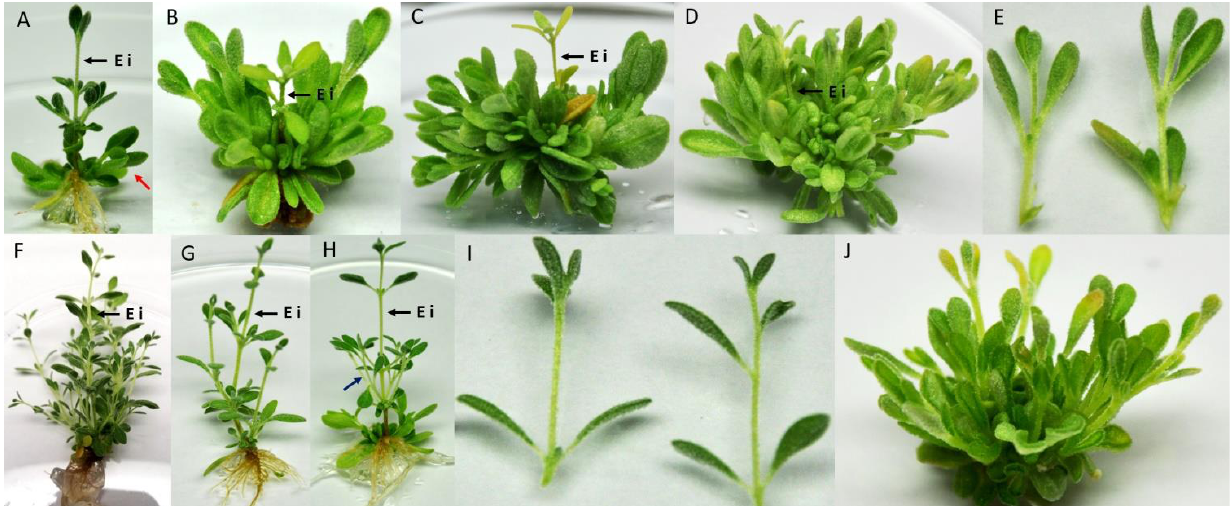
Figure 2. A. taltalensis shoots grown in vitro under different multiplication treatments: ( A ); (red arrow) Basal shoots growing in clusters from the base of initial explants in AEm2; ( B ) AEm3; ( C ) AEm4; ( D ) AEm5; ( E ) Morphological aspect of the basal shoots; ( F ) Axillary shoots and whole rooted plants growing from initial explants in AEm1; ( G ) AEmc; ( H) ; (blue arrow) AEm2; ( I ) Morphological aspect of the axillary shoots; ( J ) Hyperhydrated basal shoots subjected to treatment AEm5 during the 2nd subculture; (Ei) Initial explant.